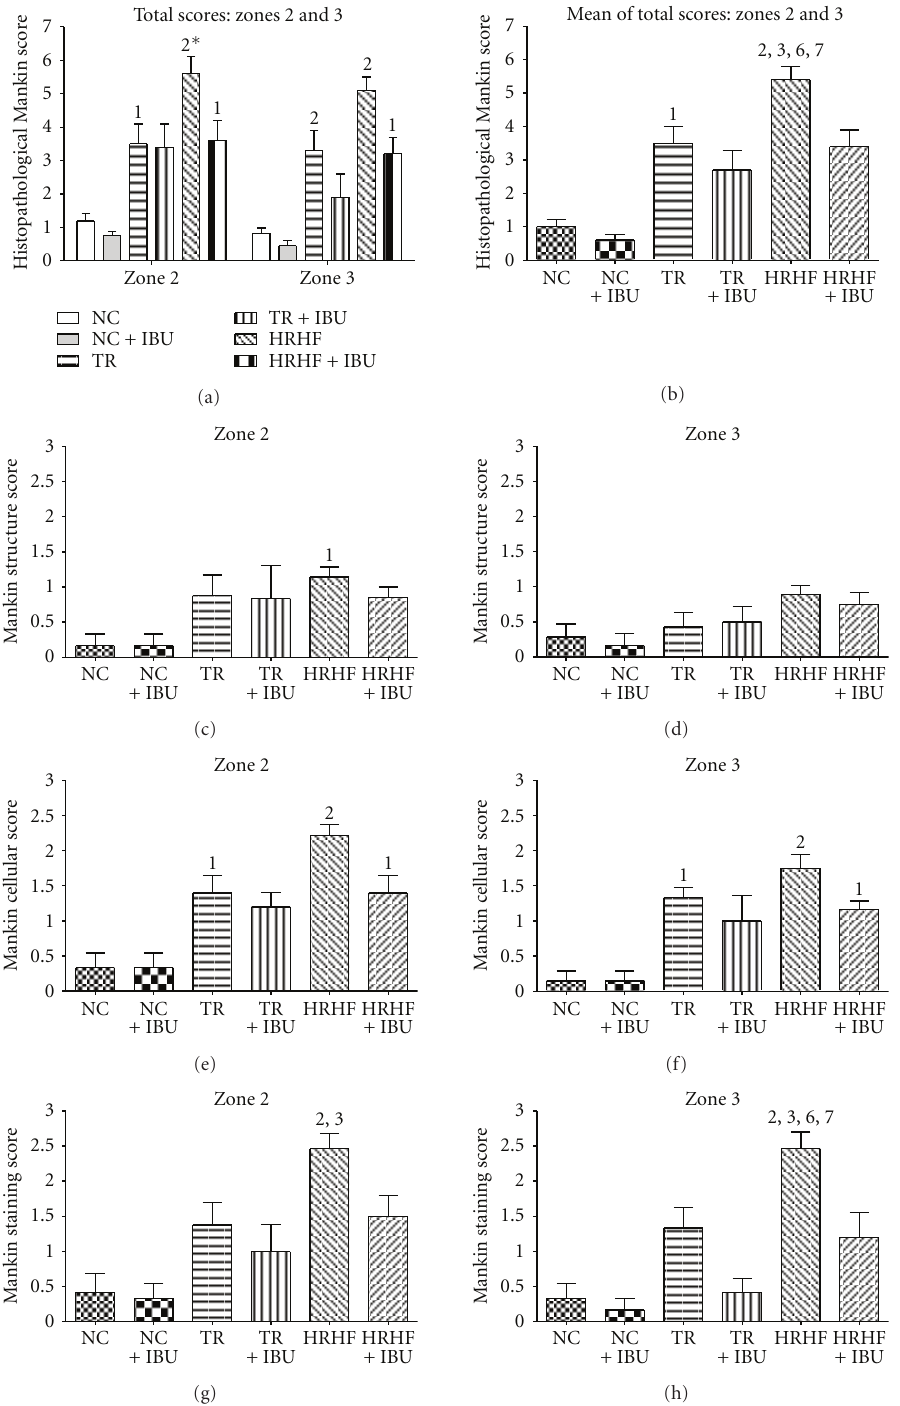
Figure 4: Histopathological Mankin scores shown for distal radius articular cartilage of the reach limb in NC (normal control), NC + IBU (normal controls receiving ibuprofen for 8 weeks), TR (trained controls), TR + IBU (trained controls receiving ibuprofen treatment in final 8 weeks), HRHF (rats performing high-repetition high-force task for 12 weeks), and HRHF + IBU (HRHF rats receiving ibuprofen treatment in final 8 weeks). (a) Total scores for zones 2 and 3 are presented separately by group. (b) Mean of total scores for both zones 2 and 3. (c) Mankin score for structural changes in zone 2. (d) Mankin score for structural changes in zone 3. (e) Mankin score for cellular changes in zone 2. (f) Mankin score for cellular changes in zone 3. (g) Mankin score for staining changes in zone 2. (h) Mankin score for staining changes in zone 3. Abbreviations: 1 and 2 = P < . 05 and P < . 01, respectively, compared to NC. 3 and 4 = P < . 05 and P < . 01, respectively, compared to TR; 5 and 6 = P < . 05 and P < . 01, respectively, compared to TR + IBU; 7 and 8 = P < . 05 and P < . 01, respectively, compared to HRHF + IBU. 2 ∗ = P < . 001 when comparing zones 2 and 3 (zone 2 is higher). Statistical results compared to NC + IBU are not presented as they were comparable to NC